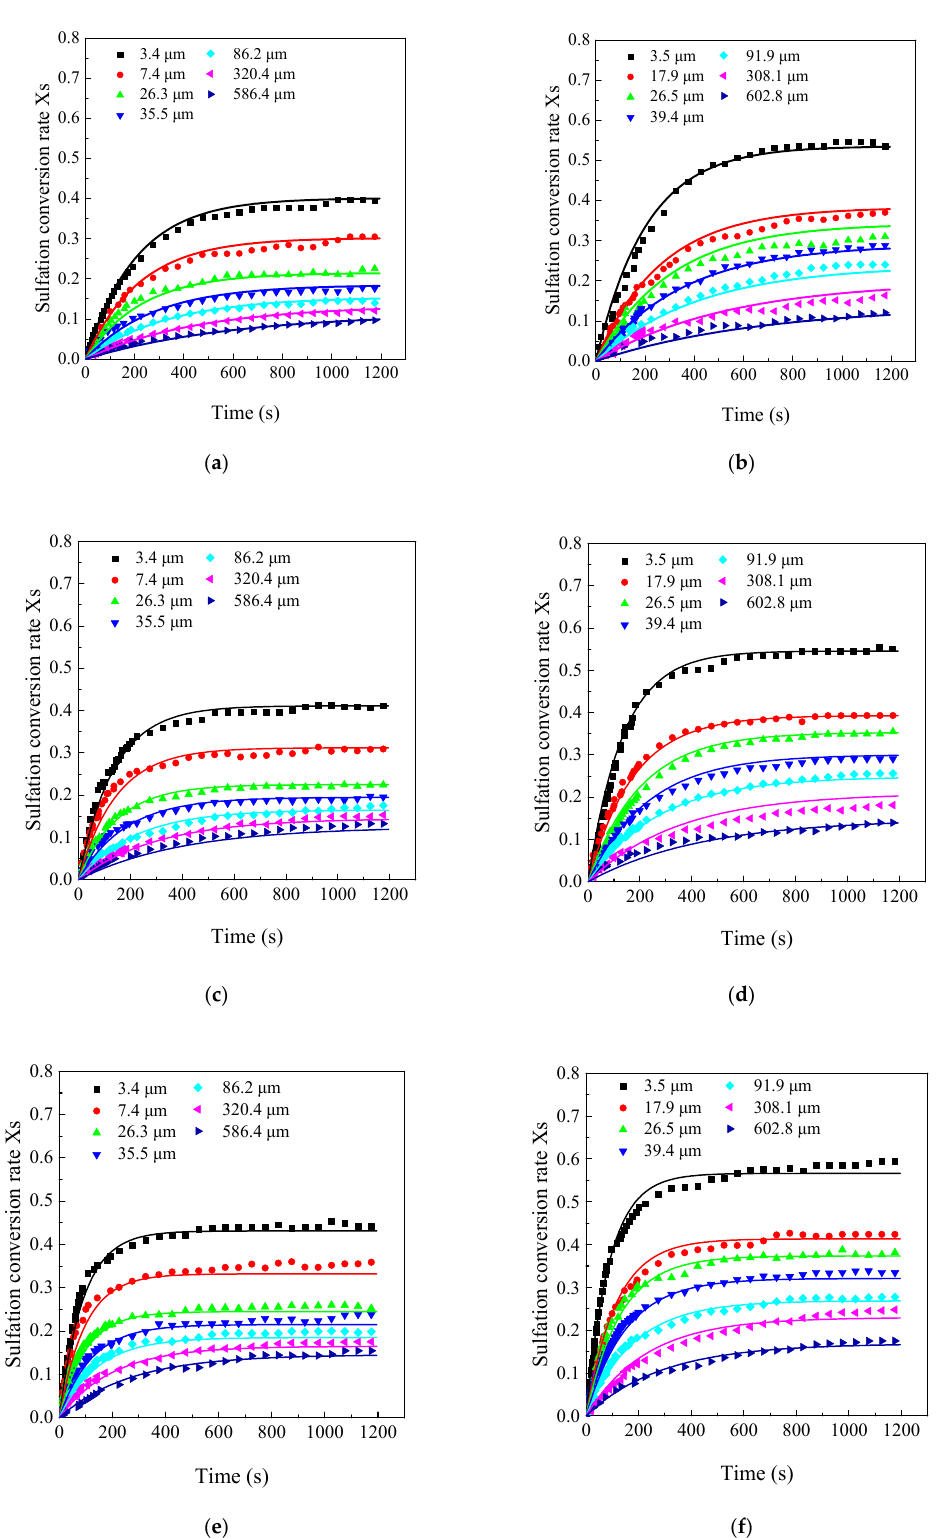
Figure 9. The sulfation conversion at different SO 2 concentrations under 850 ° C: ( a ) Samcheok, 250 ppm; ( b ) Shengzhou, 250 ppm; ( c ) Samcheok, 500 ppm; ( d ) Shengzhou, 500 ppm; ( e ) Samcheok, 1000 ppm; ( f ) Shengzhou, 1000 ppm.